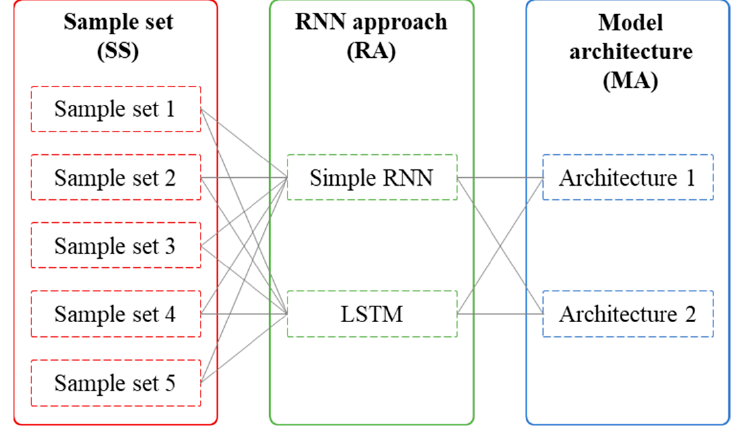
Figure 6. Machine ‐ learning time ‐ series forecasting modeling combination scheme. Figure 6. Machine-learning time-series forecasting modeling combination